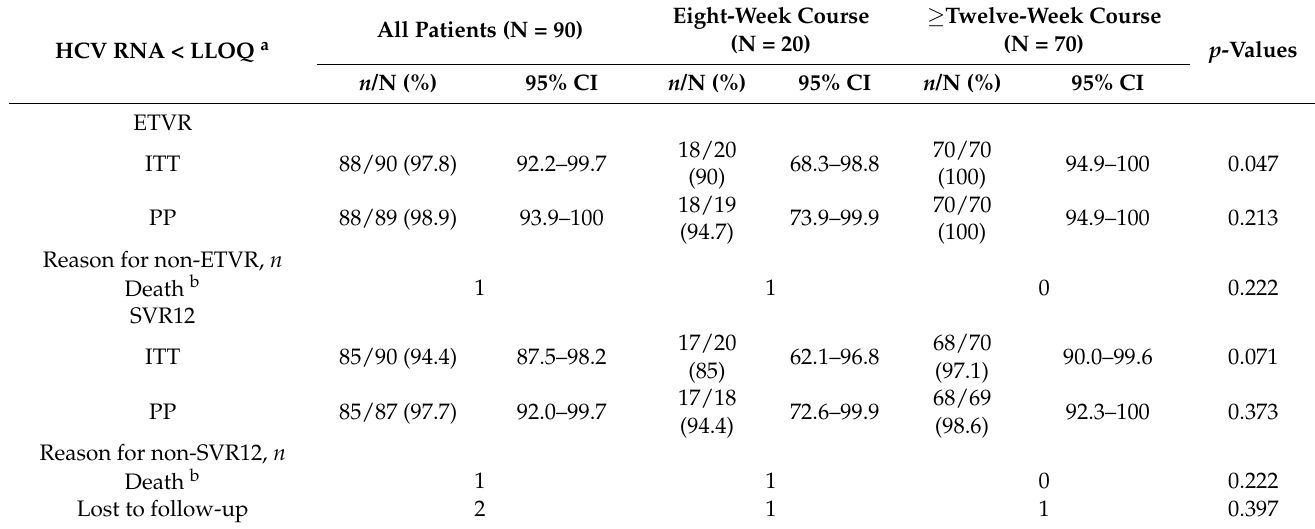
Table 2. Treatment response of the study population.